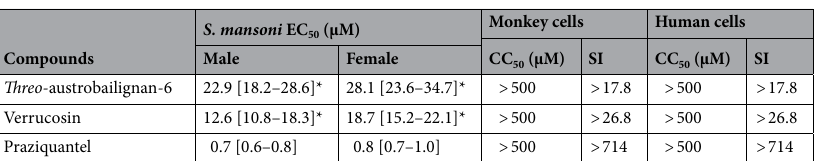
Table 1. In vitro activities of threo -austrobailignan-6, verrucosin, and praziquantel against S. mansoni adult worms and cytotoxicity. EC 50 , Effective concentration 50% against adult schistosomes; CC 50 , Cytotoxic concentration 50% against monkey (Vero) and human (HaCaT) cells; SI, Selectivity Index; *95% Confidence interval. The parasites were exposed for 72 h to the tested compounds to calculate the EC 50 . Values are calculated from three experiments, and each experiment was performed with three replicates. ND, not determined.